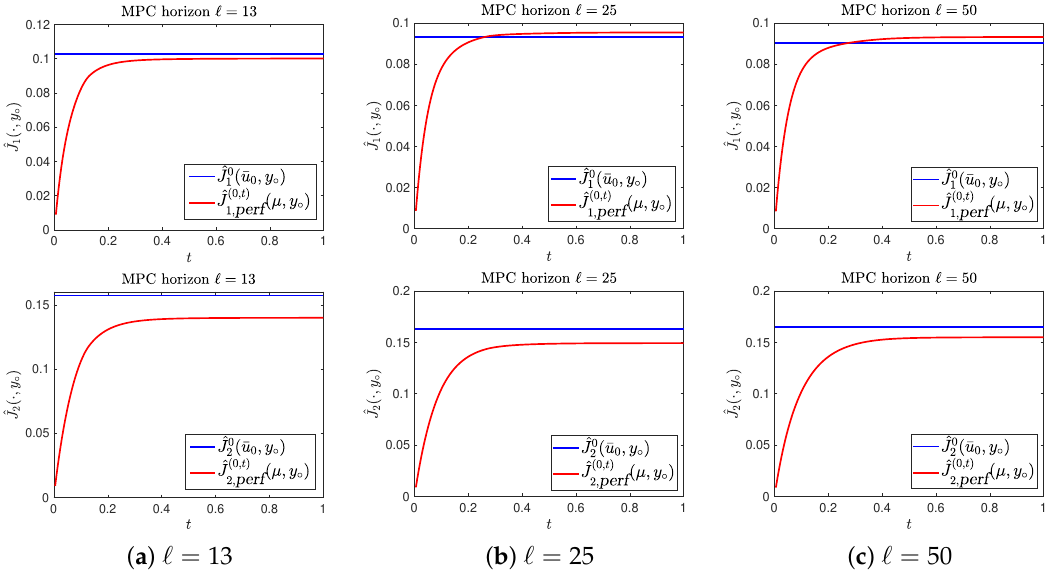
Figure 6. Performance Results for the top left point of the Pareto front.